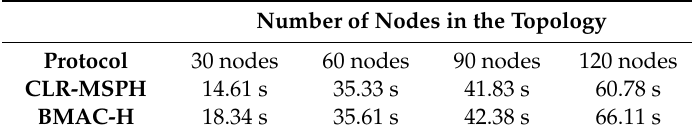
Figure 13. Energy consumption of both protocols in each topology. Table 7. The latency of delivered packets in each topology.